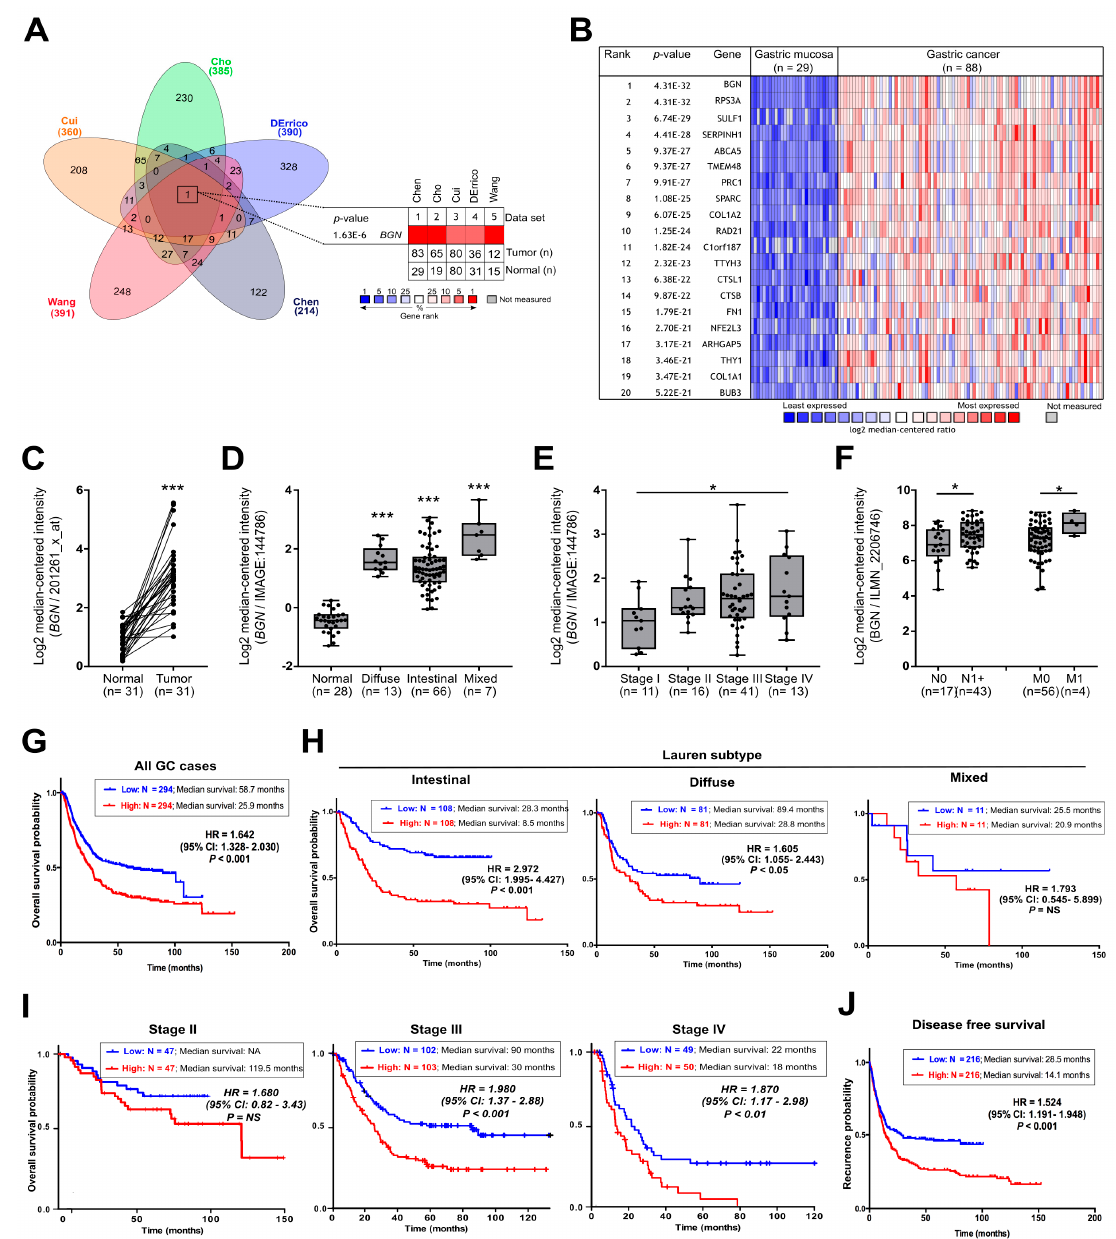
Figure 1. BGN ( biglycan ) is commonly over-expressed in gastric cancer (GC) and it is associated with tumor aggressiveness. ( A ) Venn diagram of the top 2% of genes most differential expressed in five independent GC cohorts from Oncomine database. ( B ) Heatmap of the top 20 genes more differential expressed in GC versus normal gastric mucosa from Chen cohort. BGN is the top 1 gene in the list. ( C ) BGN expression in patient tumor and normal paired-wise samples (DErrico cohort). ( D ) BGN expression according to Lauren classification (Chen cohort). ( E ) BGN expression by tumor stage (Chen cohort). ( F ) BGN mRNA levels are elevated in patients with presence of lymph node invasion (N1+) and metastasis (M1) (Cho cohort). ( G ) Kaplan–Meier analysis between BGN mRNA levels (GEO cohort from KMPlotter database) and GC overall survival. The categorization of patients’ samples was assigned into low (first tercile, lowest 33.3%) and high (third tercile, highest 33.3%) subgroups according to the levels of BGN mRNA expression. ( H ) Survival analysis according to Lauren classification. ( I ) Survival analysis by GC stage classification. ( J ) Recurrence probability/time of progression free-survival. Hazard ratios (HR) with 95% confidence intervals (CI) are shown. *, p value < 0.05; ***, p value < 0.001.